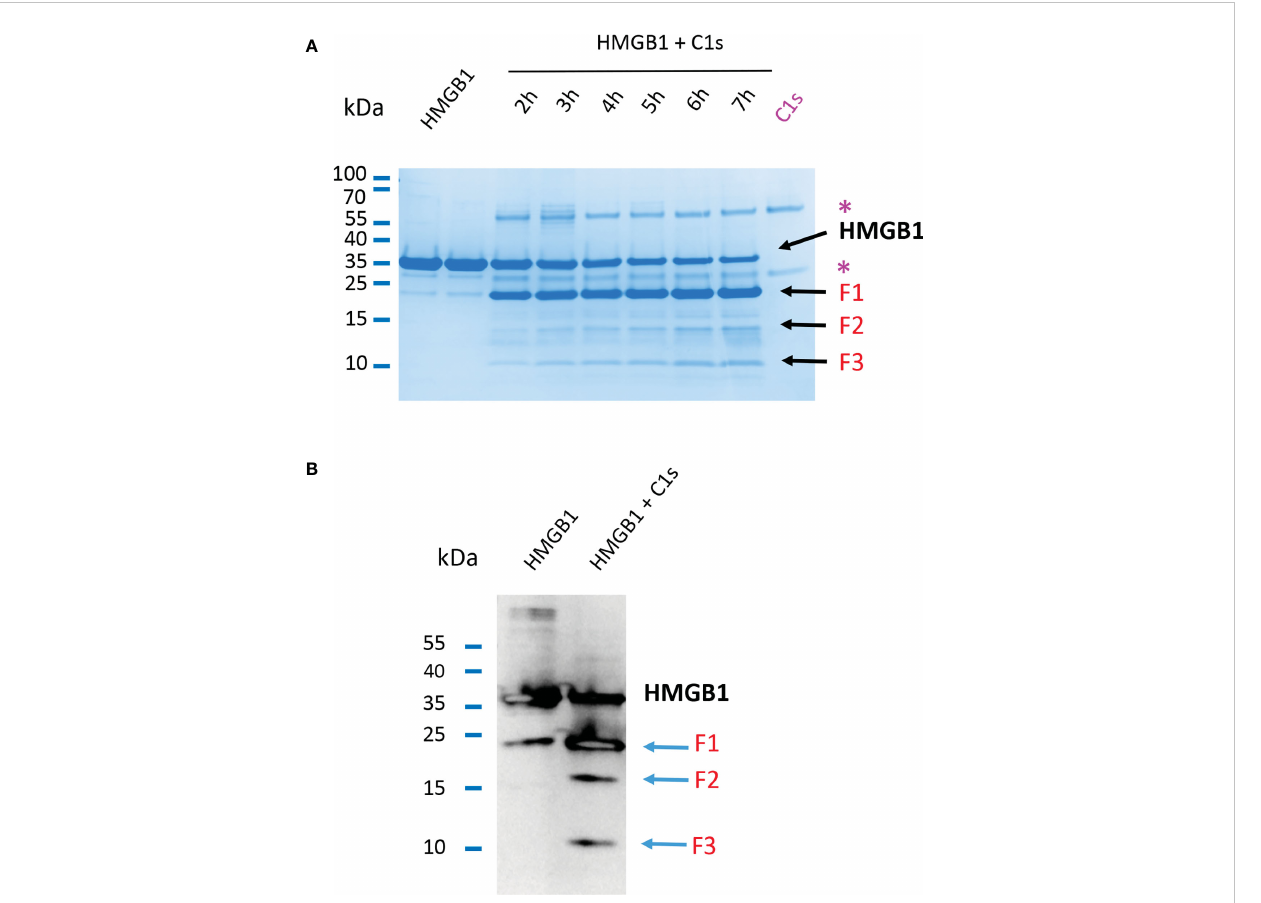
FIGURE 3 Primary and secondary C1s cleavage of HMGB1 lead to three N-terminal F1, F2 and F3 fragments. (A) 10 - 20% Tricine gel loaded with HMGB1 and HMGB1 + C1s incubated for 2 to 7 hours. Besides the main F1 fragment, which appears before 2 hours, two other bands (F2, F3) appear more lately and increase in intensity over time. Bands corresponding to C1s are labeled (*). (B) Western blot of HMGB1 and fragments incubated or not with C1s for 5 hours using an anti-HMGB1 antibody targeting its N-terminal 2 – 17 sequence. Three fragments F1 - F3 are obtained after digestion of HMGB1 (blue arrows). Speci fi city of the N-terminal antibody was veri fi ed separately (data not